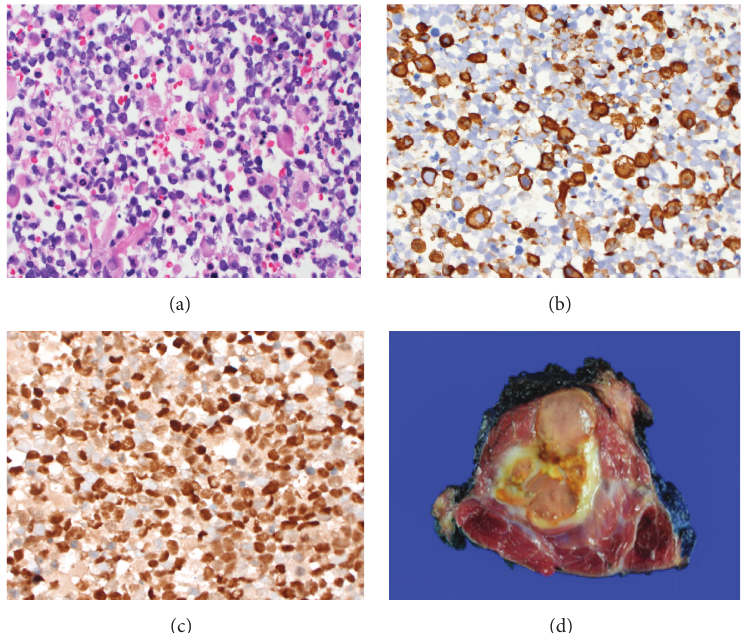
Figure 1: Gross and microscopic findings. (a) Hematoxylin and eosin (H&E) stain from fine-needle aspiration sample, prior to chemotherapy treatment, reveals a heterogeneous population of ovoid to slightly spindled cells (H&E, × 100 original magnification), (b) a subset of tumor cells are positive for desmin immunostain ( × 400 original magnification), and (c) most tumor cells are positive for myogenin (myogenin immunostain, × 400 original magnification). (d) Gross appearance of resected tumor after adjuvant chemotherapy treatment.